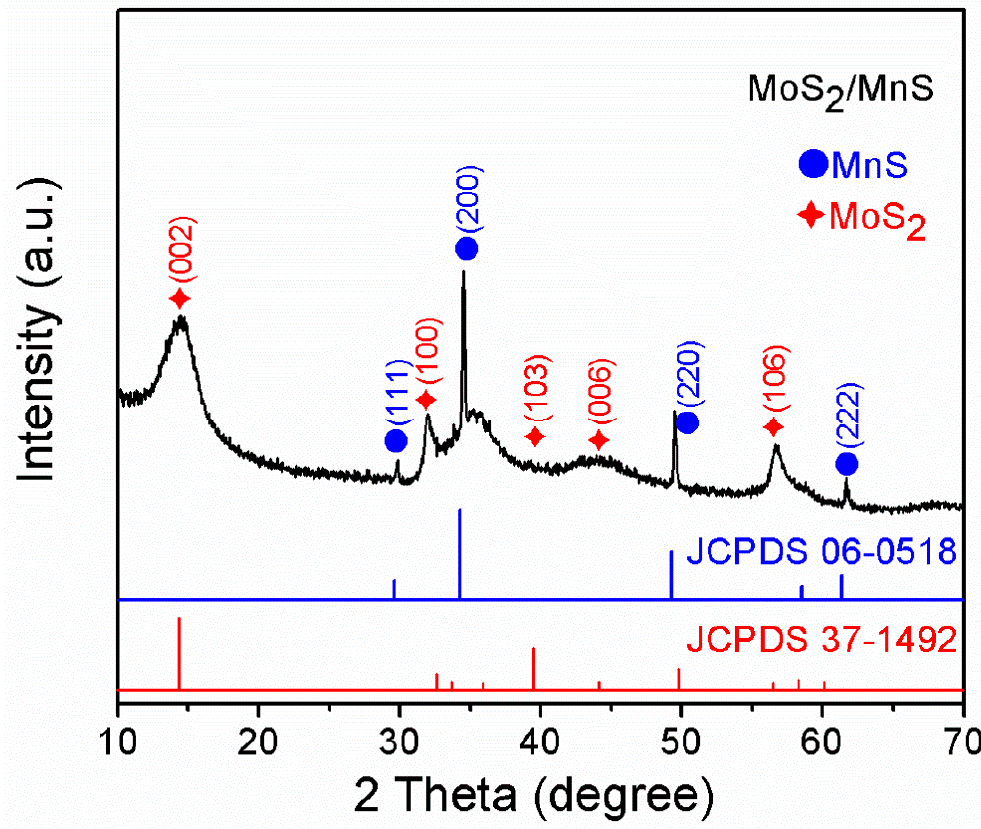
Figure 1. XRD of hierarchical MoS 2 / α -MnS nanocomposites.